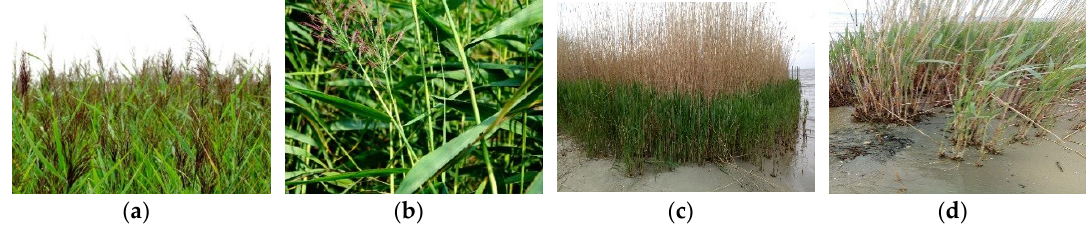
Figure 2. Phragmites australis (Photographers: Justyna Milke and Małgorzata Gałczyńska): ( a ) inflorescences in the form of panicles, ( b ) lanceolate leaves, ( c ) new green, young steams, ( d ) rhizomes